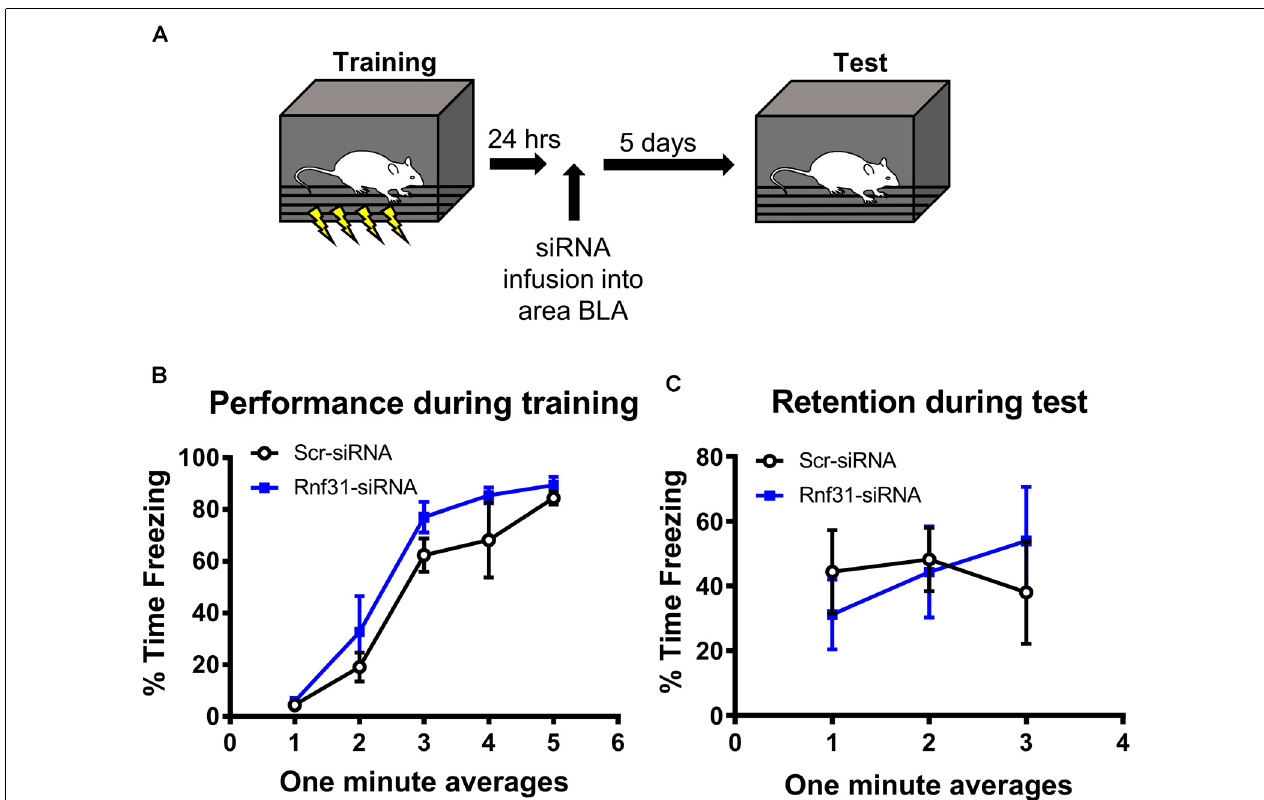
FIGURE 6 | In vivo siRNA-mediated knockdown of linear polyubiquitination in the amygdala does not impair fear memory retrieval. (A) Male rats were training to contextual fear conditioning and 24 h later received stereotaxic injections of Accell siRNA targeting Rnf31 . They were tested for memory to the training context 5 days after siRNA infusion. (B) Performance during the fear conditioning task. (C) Knockdown of Rnf31 did not alter performance during the test session. N = 5 per